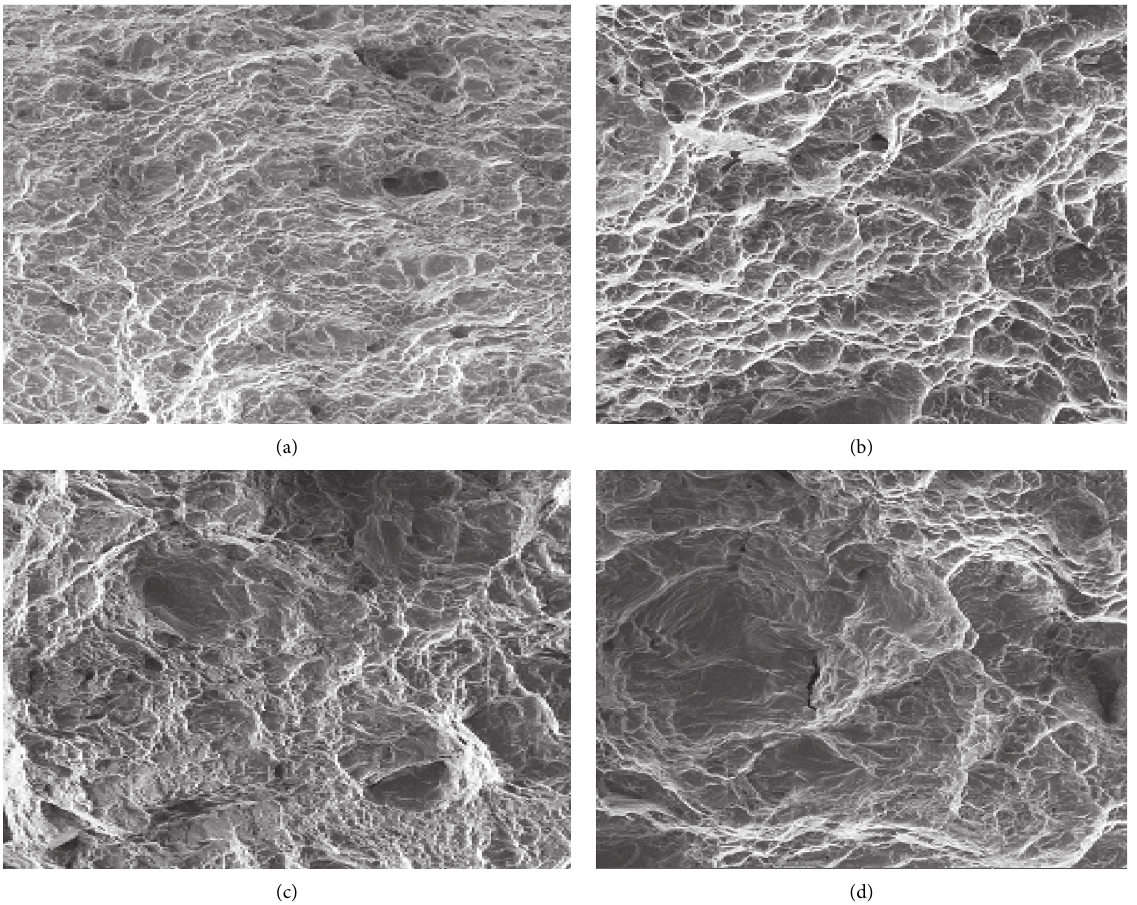
Figure 6: Fracture morphology of different samples after the tensile test: (a) parent, (b) 30min, (c) 60min, and (d)